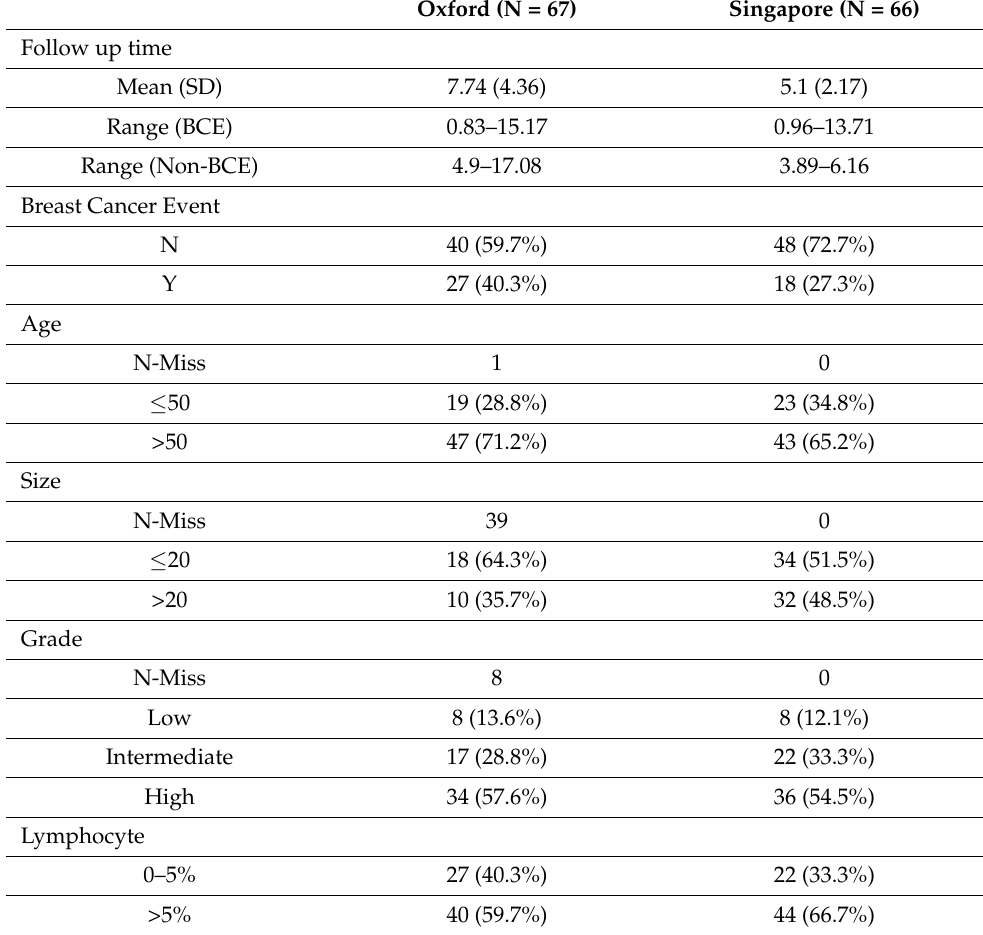
Table 1. Patient Characteristics for each